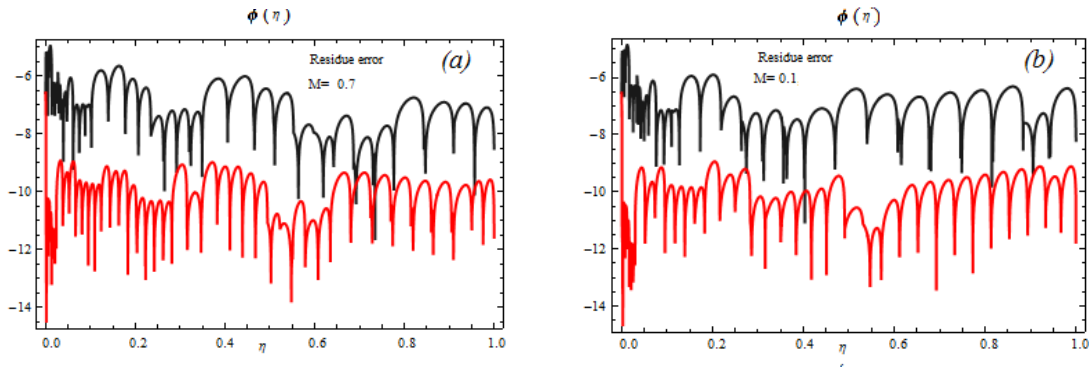
Figure 7. Residue error for concentration for physical parameters ( a ) 𝑀 (cid:3404) 0.7 and ( b ) 𝑀 (cid:3404) 0.1 .